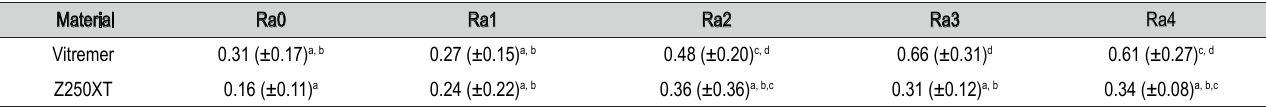
Table 4 - Mean values (Standard deviation) of Roughness (µm) of Vitremer and Z250 XT observed in the periods T0, T1,